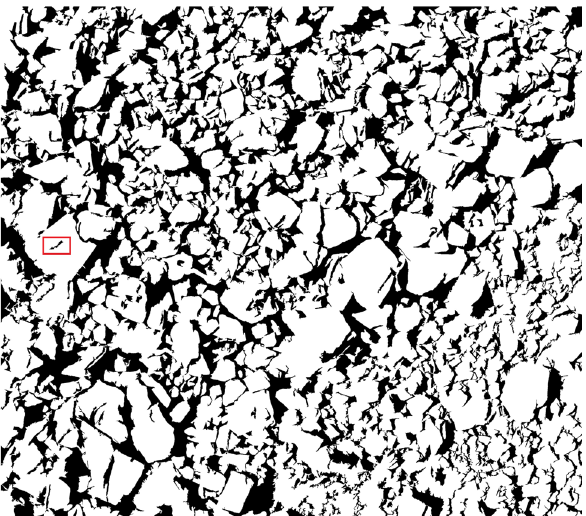
Figure 16. Granite blasted rock binary